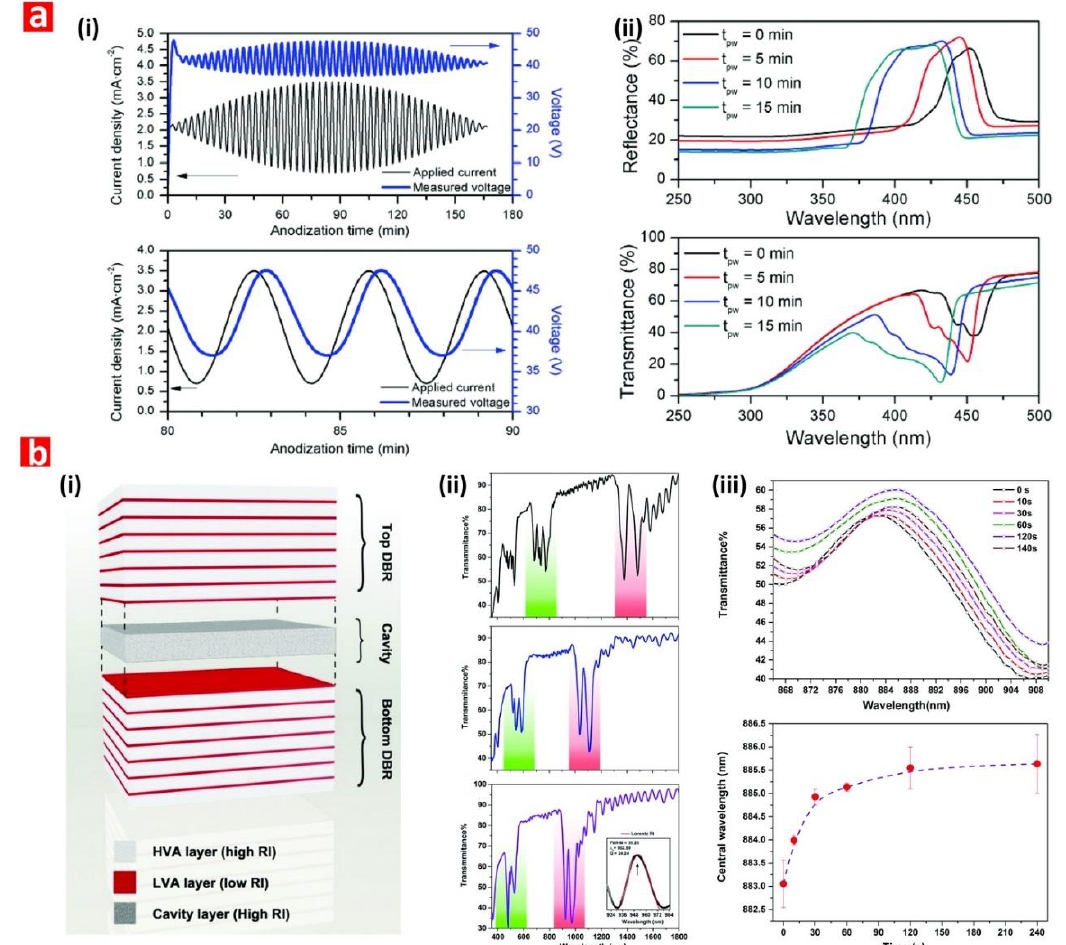
Figure 11. Examples of applicability of NAA-PCs in chemo- and biosensing applications. ( a ) ( i ) SPA profile used to produce NAA-GIFs and ( ii ) reflection and transmission spectra of NAA-GIFs as a function of the pore-widening time. Reproduced with permission from authors of a previous paper [81]. Copyright Springer, 2014. ( b ) ( i ) Schematic showing the structure of NAA- µ CVs with two NAA-DBR mirrors and a layer of constant porosity in between, ( ii ) transmission spectrum of NAA- µ CVs showing how the resonance band blue-shifts with the pore-widening time, and ( iii ) detection of humidity level based on red shifts in the resonance band of NAA- µ CVs. Reproduced from [83], with copyright permission from American Chemical Society, 2015.